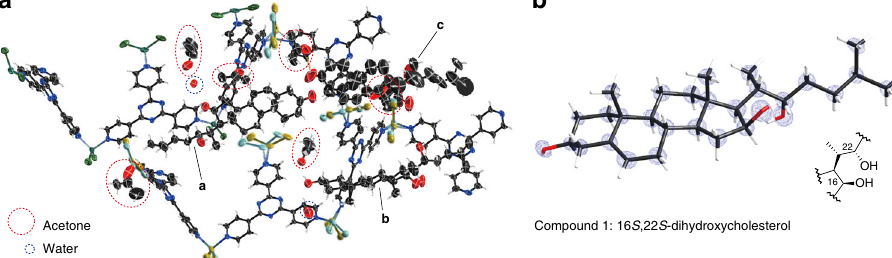
Fig. 3 Absolute structural elucidation of 1 by crystalline sponge X-ray diffraction analysis. a ORTEP diagram with 50% probability showing the asymmetric unit (ASU) of crystalline sponge-compound 1 complex. A single crystal of [(ZnCl 2 ) 3 (tpt) 2 ] n [tpt = 2,4,6-tri(4-pyridyl)-1,3,5-triazine] was used as the crystalline sponge. Three crystallographically independent molecules of 1 were observed in the ASU a – c . The solvent molecules acetone and water are highlighted by red and blue circles, respectively. b The structural model of 1 overlaid on the electron density map F o contoured at the 2.0 σ level (2.6 eÅ − 3 ). The absolute stereochemistry of C16 and C22 is